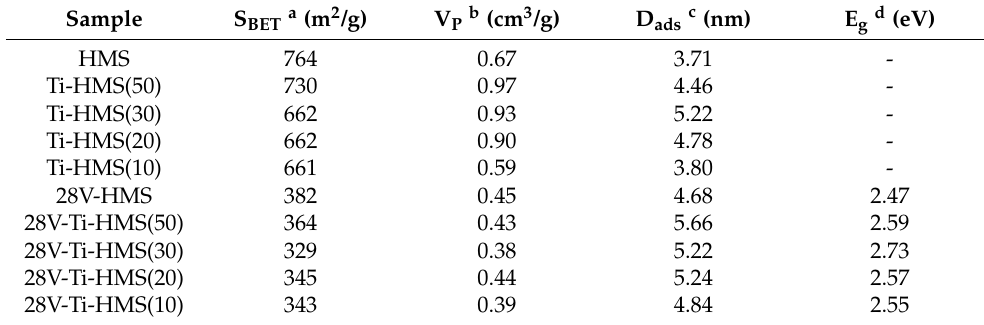
Table 1. Textural properties and Eg of the materials.